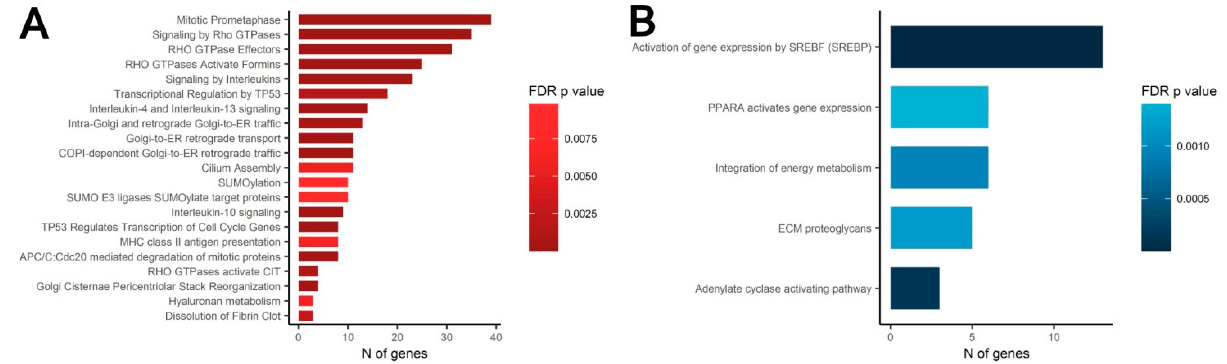
Figure 8. Reactome pathway analysis between the cells of CS-condensed and CS-scattered areas. ( A ) The bar plot shows the number of upregulated genes associated with the top Reactome pathways and the adjusted p -values for these pathways (assigned by color). Plot displays the top pathways by the number of genes related to the Reactome pathway (total number of significant genes (ntotal) is 239). ( B ) The number of downregulated genes associated with the top Reactome pathways (ntotal = 112).